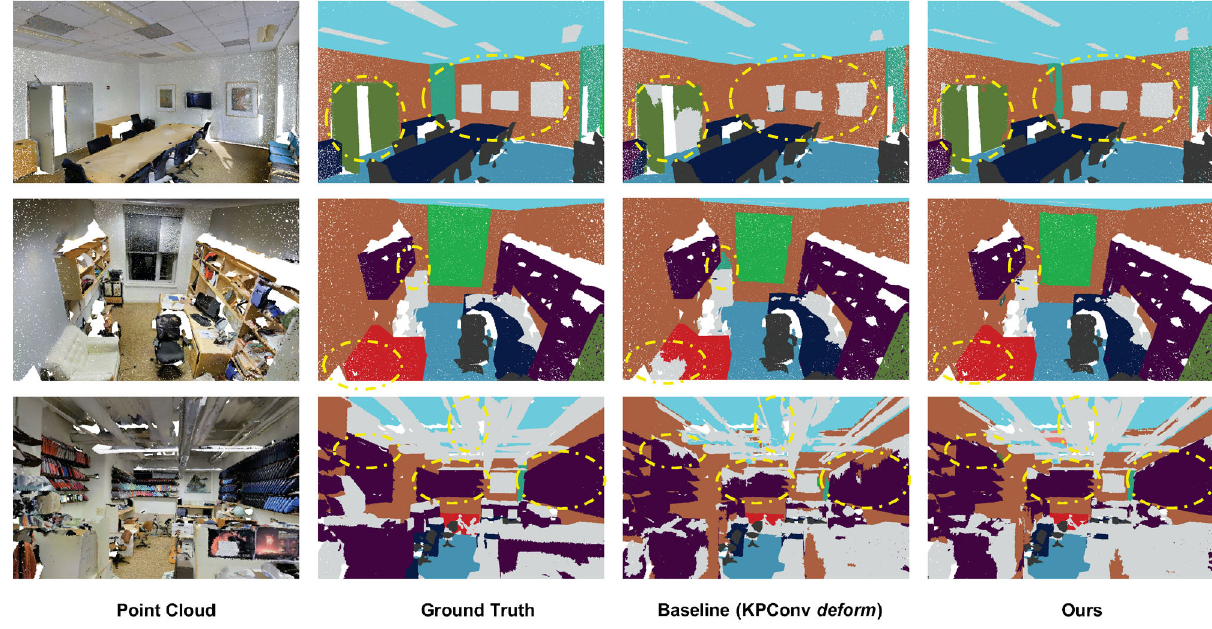
Fig. 4 Visual results for semantic segmentation on S3DIS